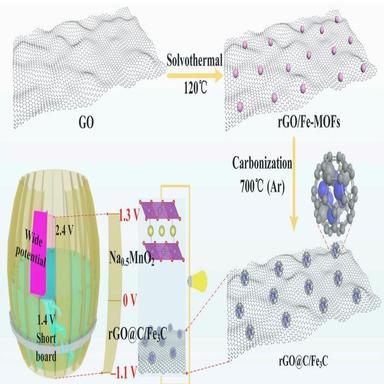
Graphic illustration of the fabrication and application of the rGO@C/Fe3C material.